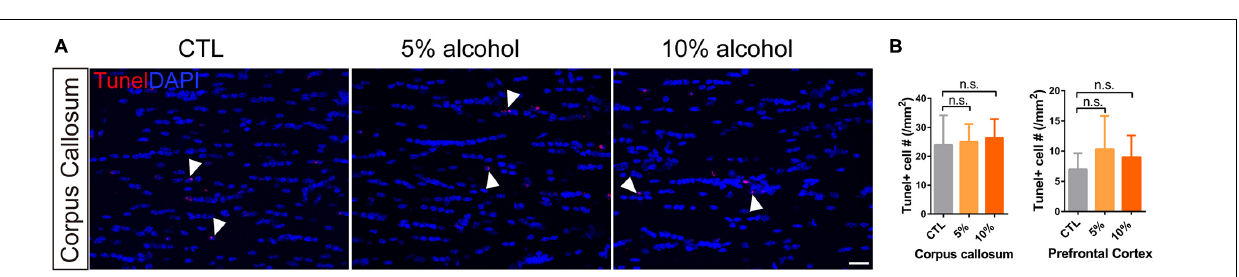
FIGURE 5 | Chronic alcohol treatment does not change cell apoptosis level in adult mice brain. (A) Tunel staining showing a few apoptotic cells (arrowheads) in the corpus callosum. Scale bar 20 µ m. (B) Quantification of Tunel positive cell in the corpus callosum and prefrontal cortex (n.s. p = 0.93 and 0.62, n =